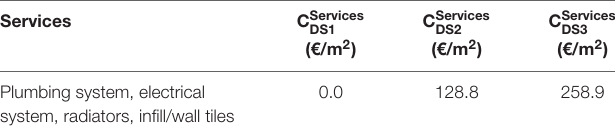
TABLE 3 | Costs for services at each DS per plan surface